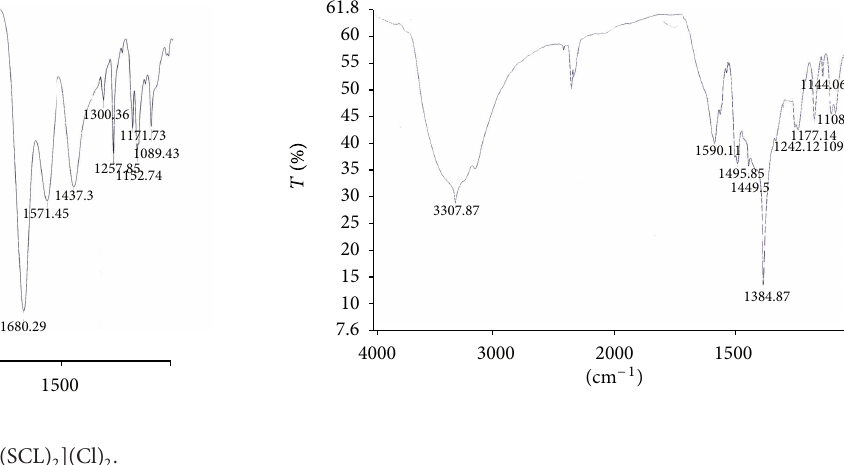
F 5: IR spectra of [Co(SCL)